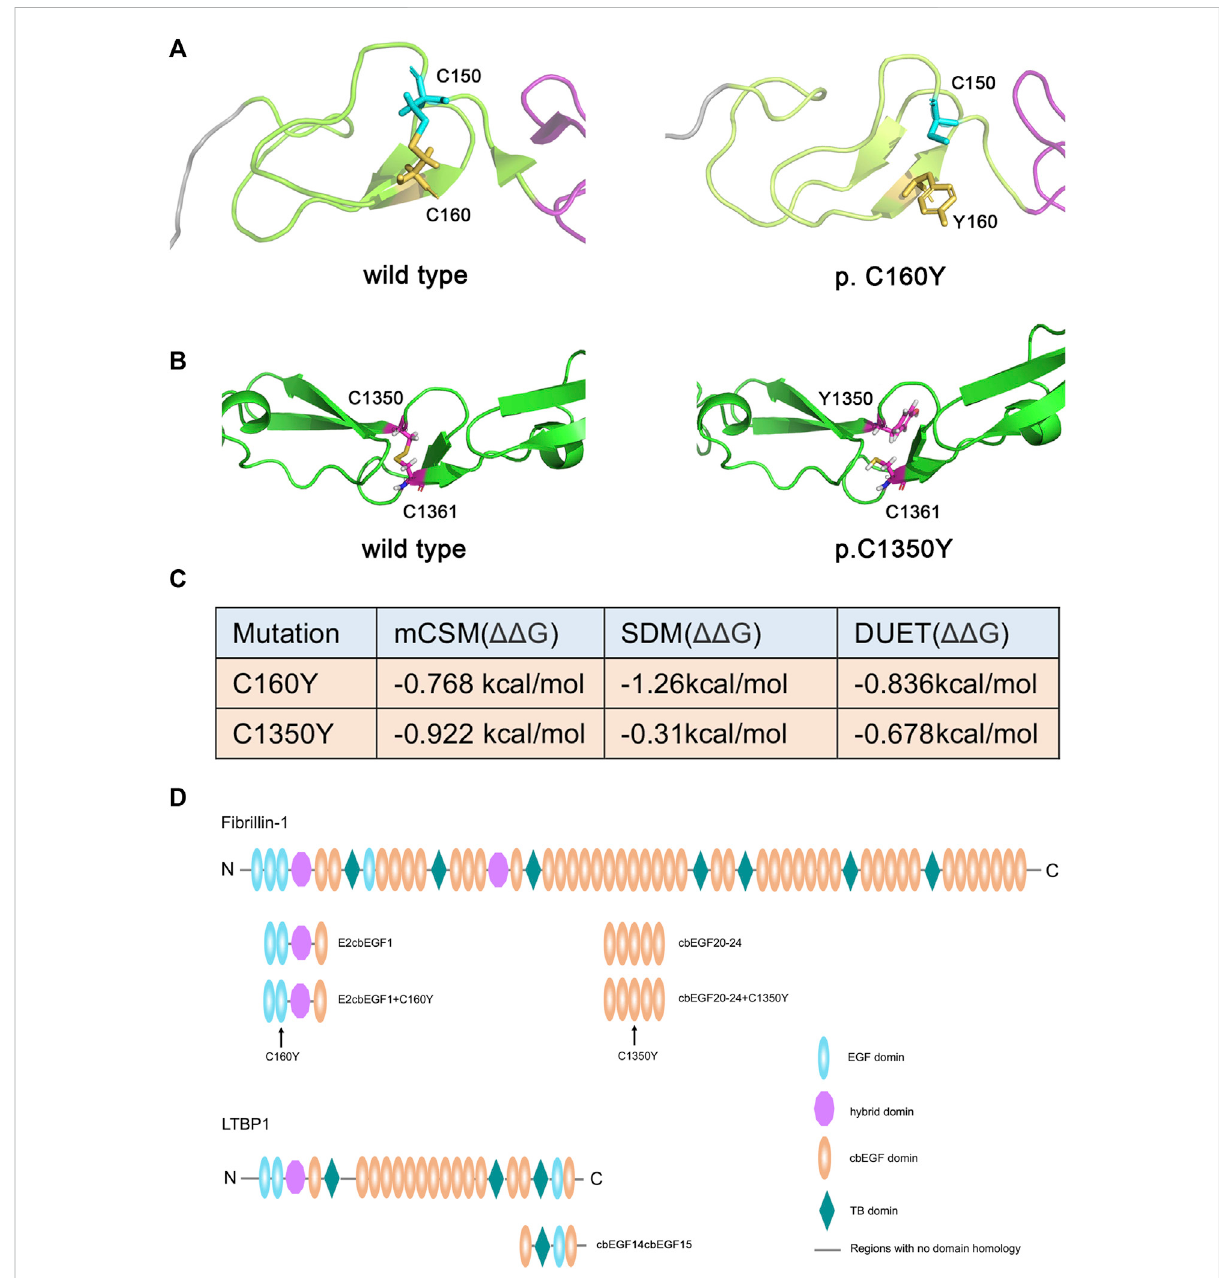
FIGURE 2 Effects of variants on the structure and stability of the fi brillin-1 protein. (A) Three-dimensional structural map of the EGF2 domain to cbEGF1 domain of fi brillin-1 without (left) or with the C160Y mutation (right). (B) Three-dimensional structural map of the cbEGF20 domain to cbEGF24 domain of FBN1 without (left) or with the C1350Y mutation (right). (C) Stability analysis of the wild-type and mutant fi brillin-1 proteins. (D) Schematic drawing of the recombinant polypeptides. The position of the fi brillin-1 C160Y and C1350Y mutations are indicated by